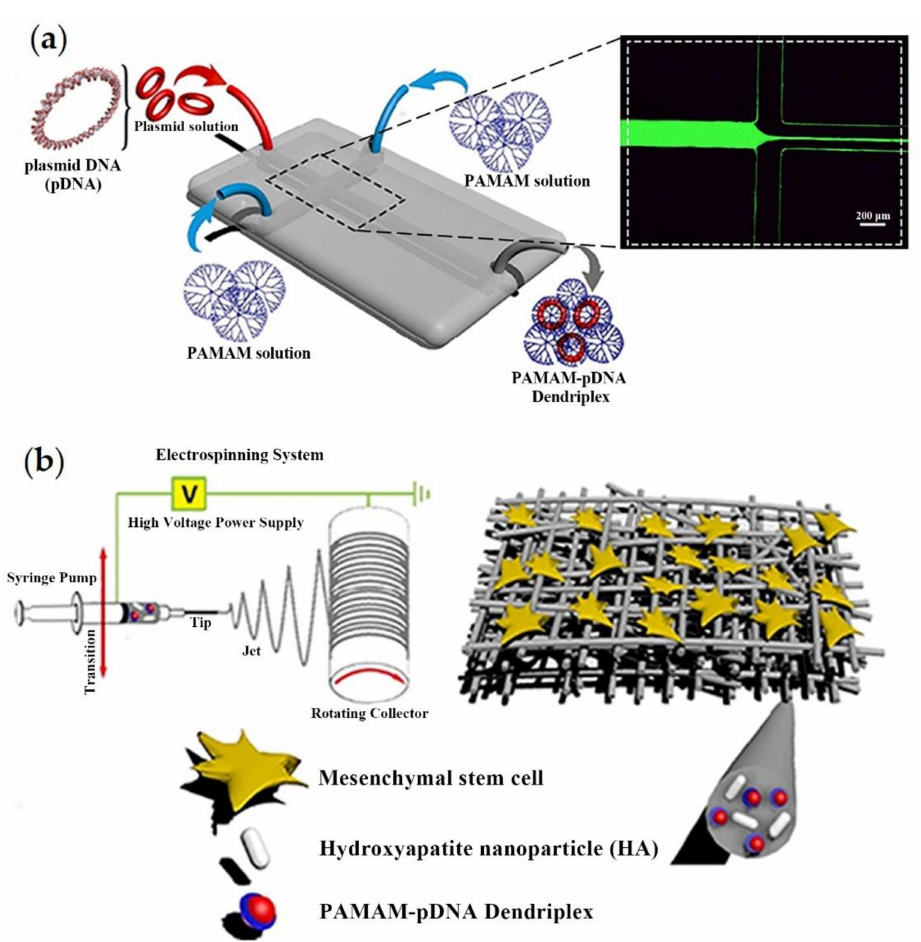
Figure 11. ( a ) Schematic representation of MF preparation of drug-loaded carriers and ( b ) scaffolds fabrication. Reprinted from [93] with CC-BY license. Copyright © 2021 Doosti-Telgerd et al.